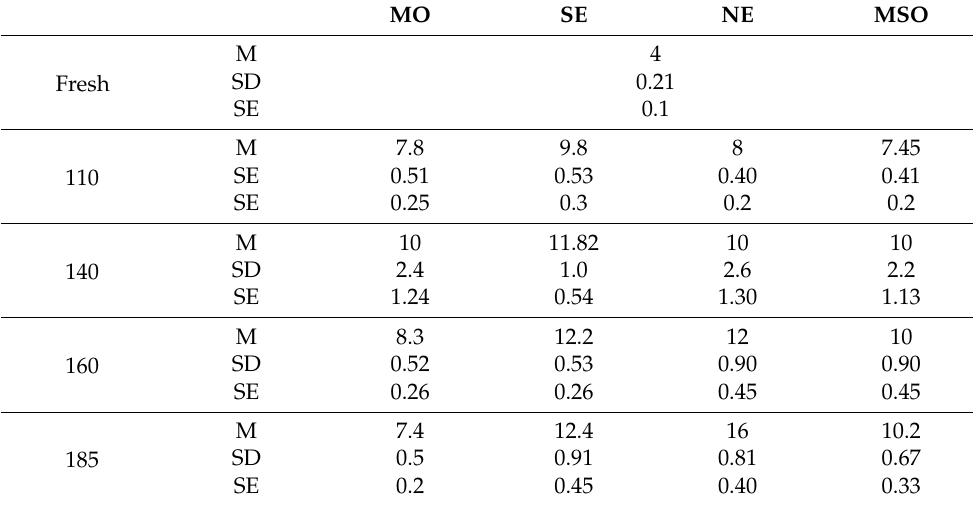
Table 1. Statistical analysis of BDV for 0.5 mm thickness paper with